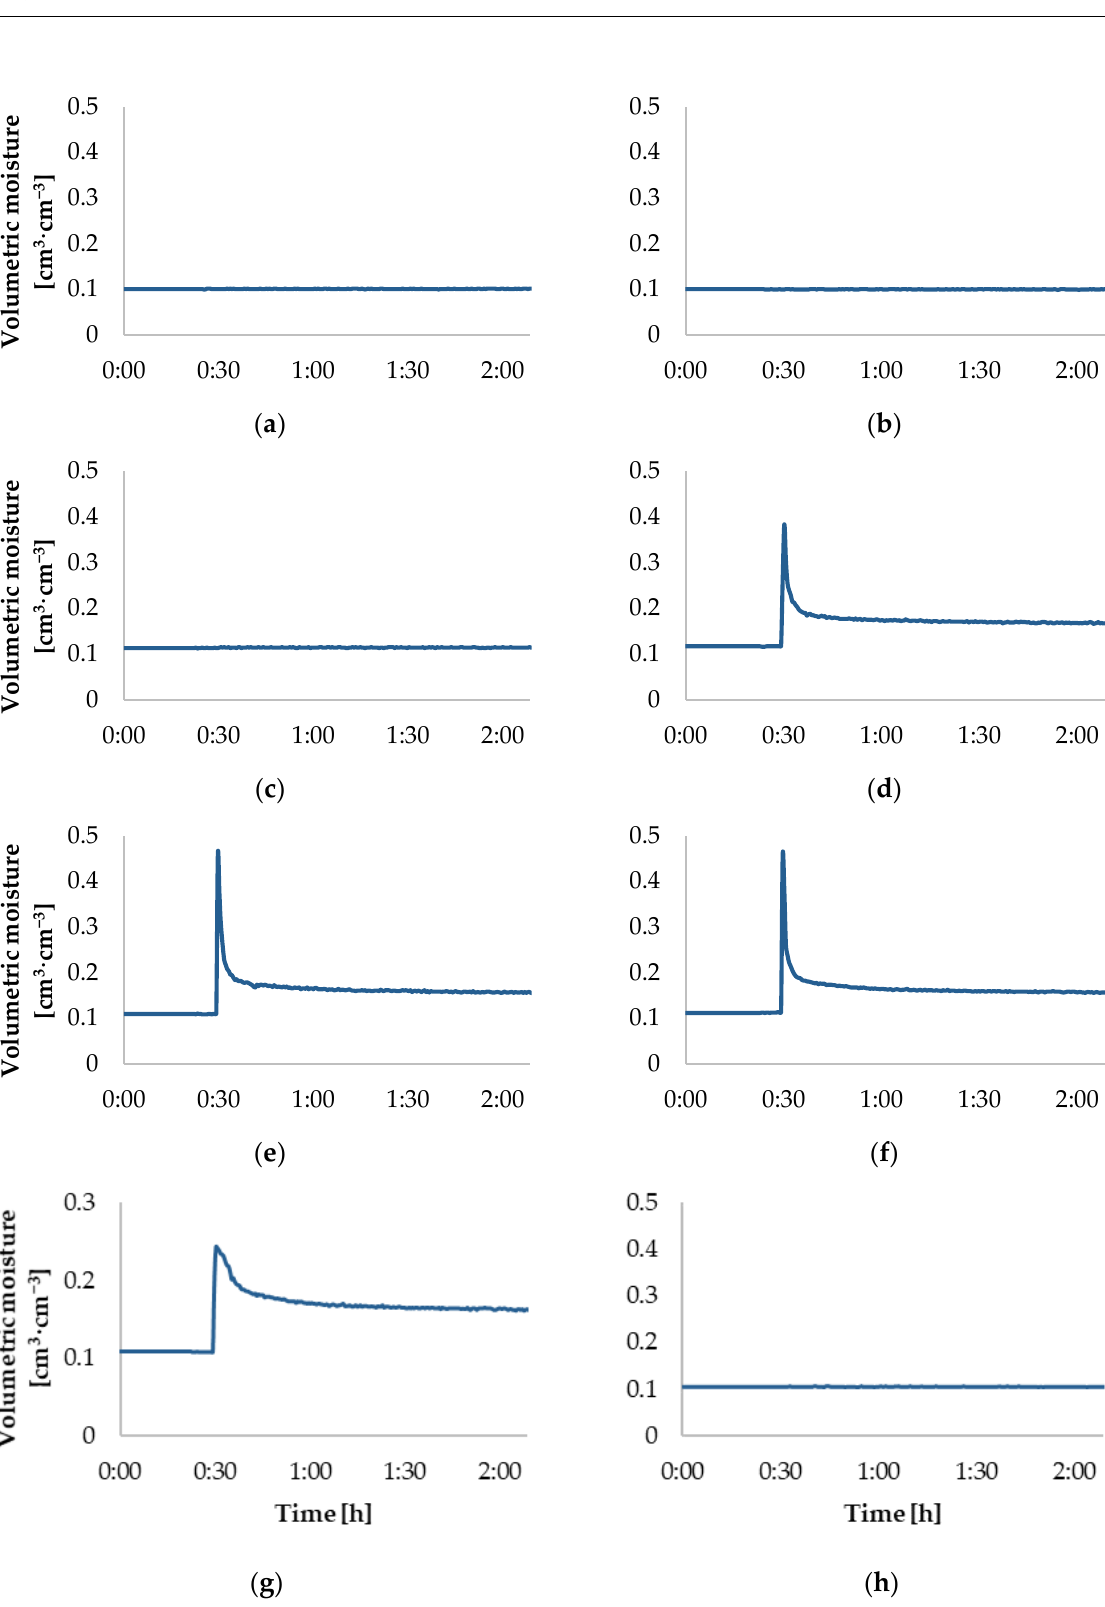
Figure 6. Dynamics of volumetric moisture in eight elementary volumes with centre points situated on the line of water outflow from the injector—axis 0Y i (dose of 1500 cm 3 ). Elements ( a – h ) were described in Figure